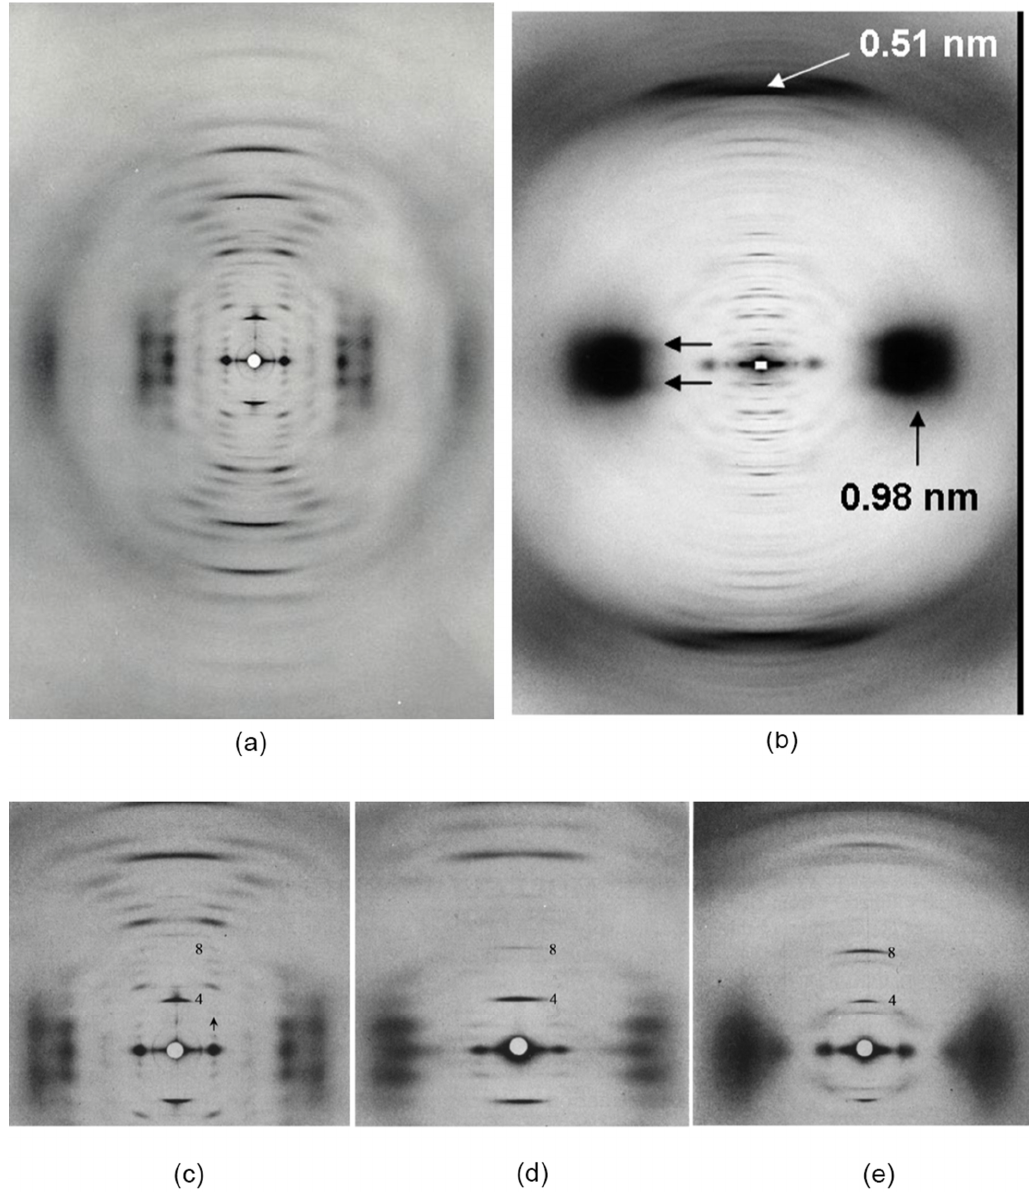
Figure 3. High angle X-ray diffractions patterns of ( a ) seagull feather rachis ( Larus novae-hollandiae ), which shows features of a ß-conformation, and ( b ) porcupine quill ( Hystrix cristata ), which is based on the α -conformation with its characteristic 0.51 nm meridional reflection and the 0.98 nm equatorial and near-equatorial reflections, ( c , d ) show the same seagull feather rachis before and after pressing in steam to remove the lateral organisation between the filaments and ( e ) goanna claw ( Varanus varius ). ( b ) reproduced from [43] with permission of Elsevier; ( a – e ) reproduced from [44] with permission of Elsevier.